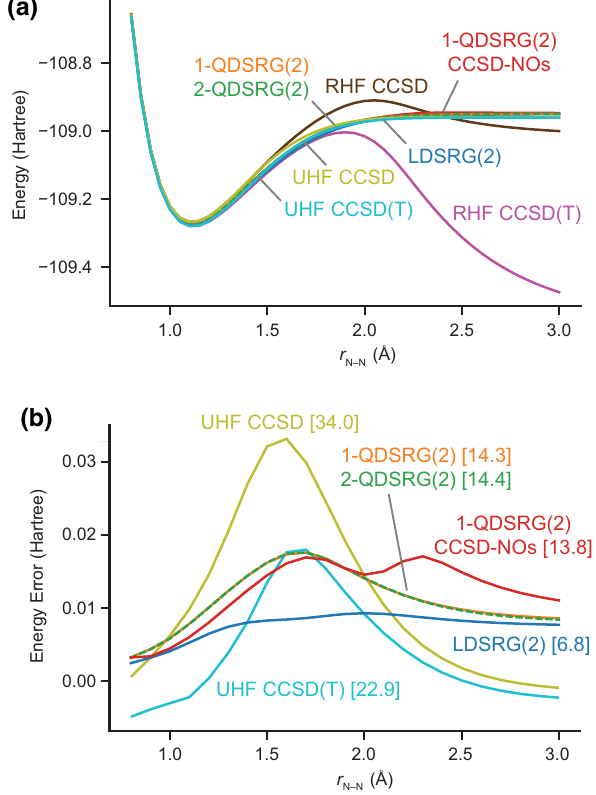
FIG. 3. The dissociation curve for the ground-state N 2 com- puted with the LDSRG(2) and QLDSRG(2). (a) The total energy and (b) the energy error with respect to FCI in units of E h